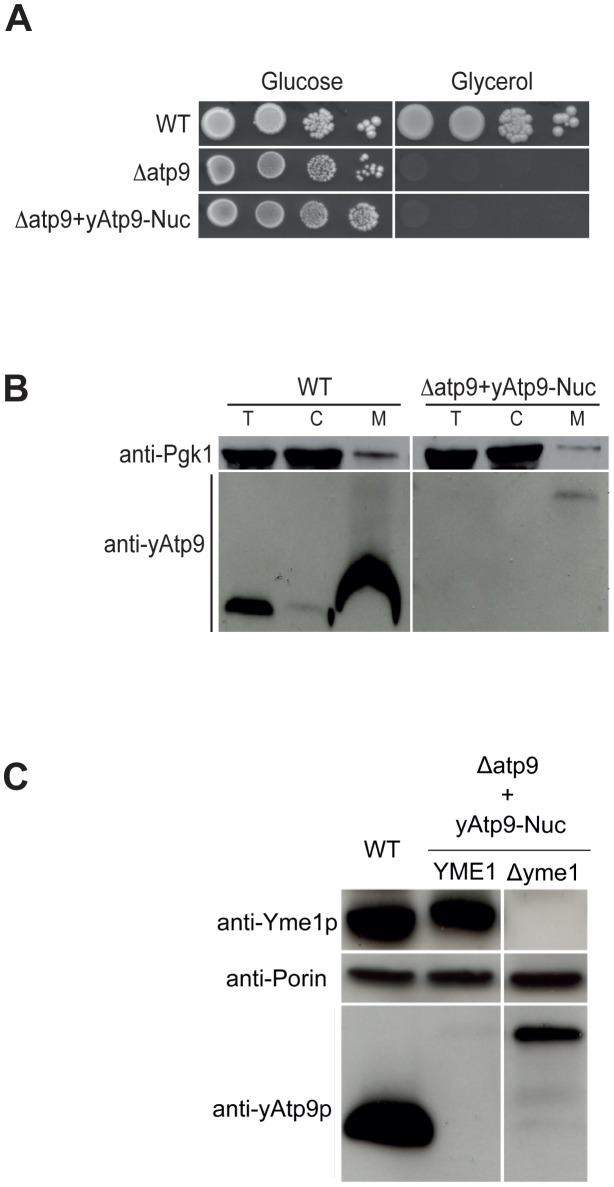
A nuclear version of the yeast mitochondrial ATP9 gene fails to complement the Δatp9 yeast.We engineered a nuclear version of the yeast ATP9 gene (yAtp9-Nuc) by adding a mitochondrial targeting sequence (derived from the P. anserina Atp9-7 gene) and adjusting the genetic code for nuclear expression of the endogenous gene (see Figure S2 and S3A for amino acid and nucleotide sequences). yAtp9-Nuc was tested for its capacity to complement Δatp9 yeast with respect to respiratory capacity. A) Growth on rich glucose (YPGA) and glycerol (N3) media of serial dilutions of WT, Δatp9, and Δatp9 transformed with yAtp9-Nuc. B) Total cellular (T), mitochondrial (M) and post-mitochondrial supernatant (C) protein extracts were prepared from WT and Δatp9+yAtp9-Nuc strains. Samples were separated via SDS-PAGE and probed with antibodies against yeast Atp9p and the cytosolic protein Pgk1p (phosphoglycerate kinase). C) Western blot of total proteins prepared from WT and Δatp9 yeast transformed with yAtp9-Nuc with or without the YME1 gene (Δyme1) reveals that the yAtp9-Nuc protein is degraded by the i-AAA protease (an oligomer of Yme1p).